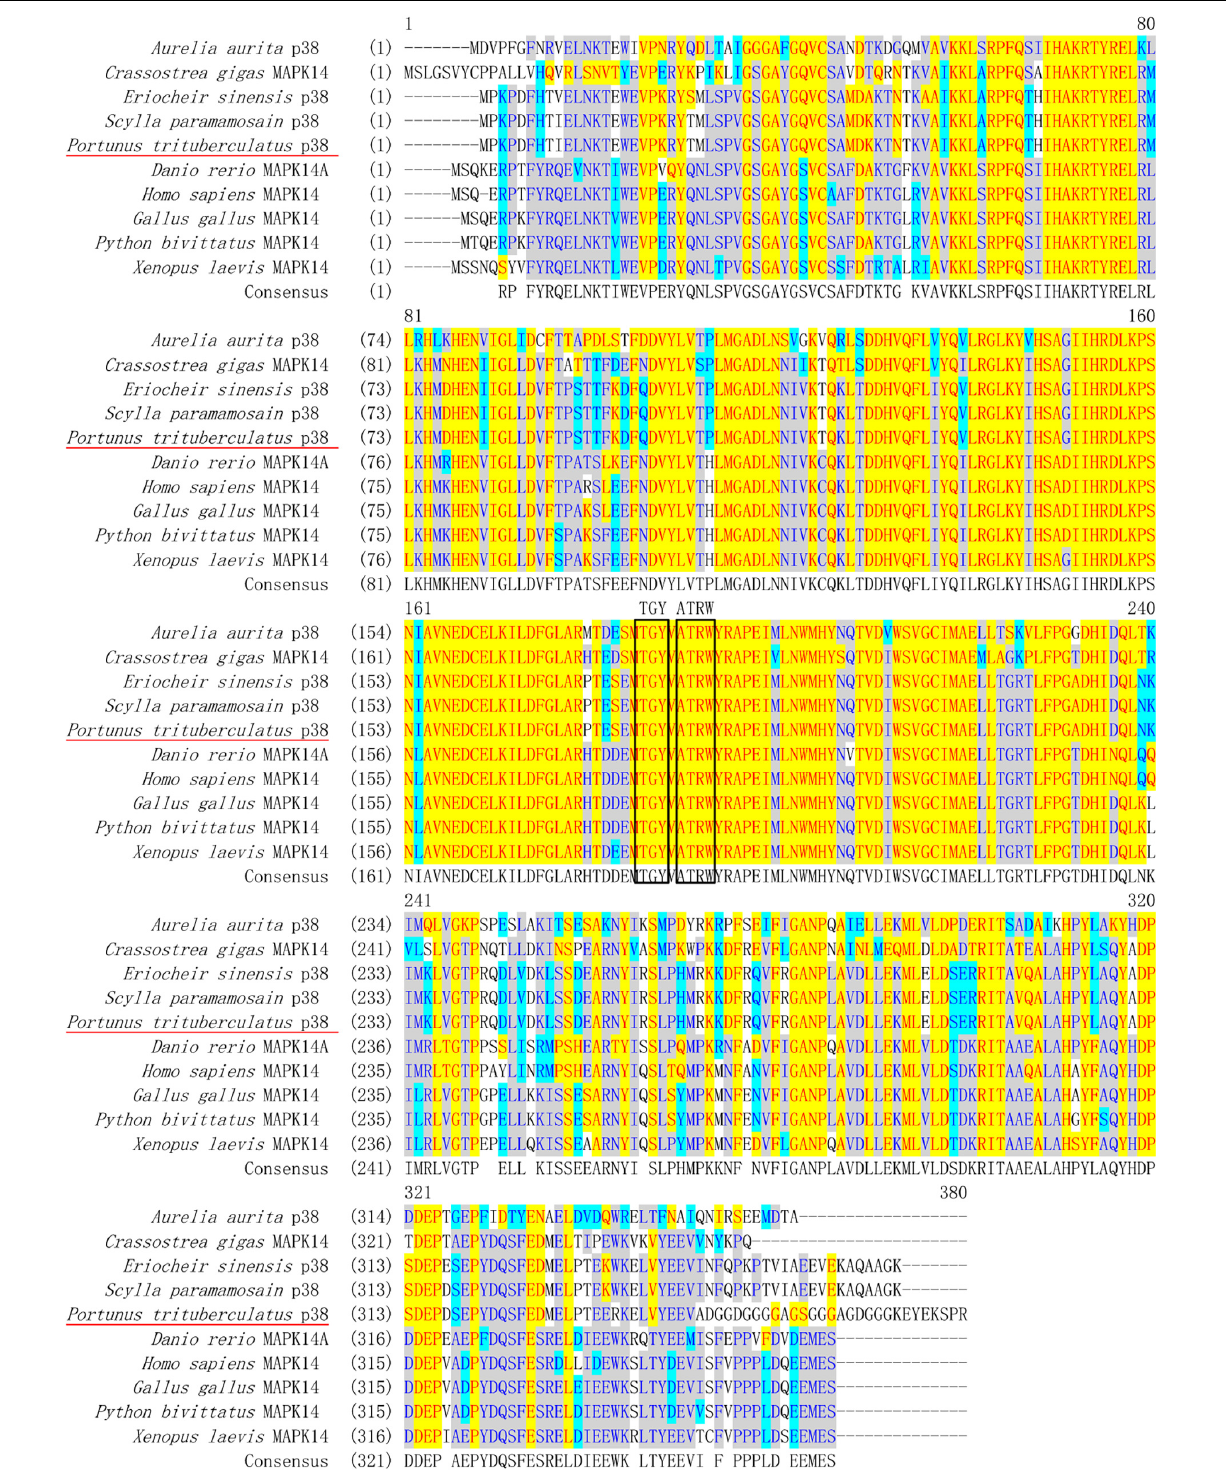
Frontiers in Marine Science |